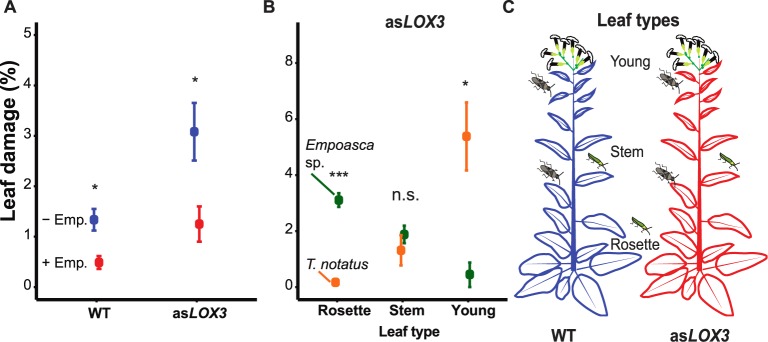
T. notatus causes less damage on Empoasca sp. co-infested N. attenuata plants (WT and asLOX3) and these herbivores have opposite preferences for young and old leaves.Values are mean±SE. (A) T. notatus caused significantly less damage on Empoasca sp. co-infested plants on WT and asLOX3 plants. (B) Empoasca sp. feeds generally more on asLOX3 and caused more damage to asLOX3 rosette leaves than T. notatus; the opposite pattern was observed on young leaves (data are for herbivores feeding on asLOX3 N. attenuata plants). (C) Description of within-plant damage distribution and leaf positions on asLOX3 N. attenuata plants attacked by the herbivores. Damage data were arcsin square root transformed. *P < 0.05 in Student’s t-tests between treatments (+/- Empoasca sp.) within each genotype, ***P < 0.001 in Student’s t-tests and *P < 0.05 in Wilcox test between insects within each leaf type. n.s. = not significant.